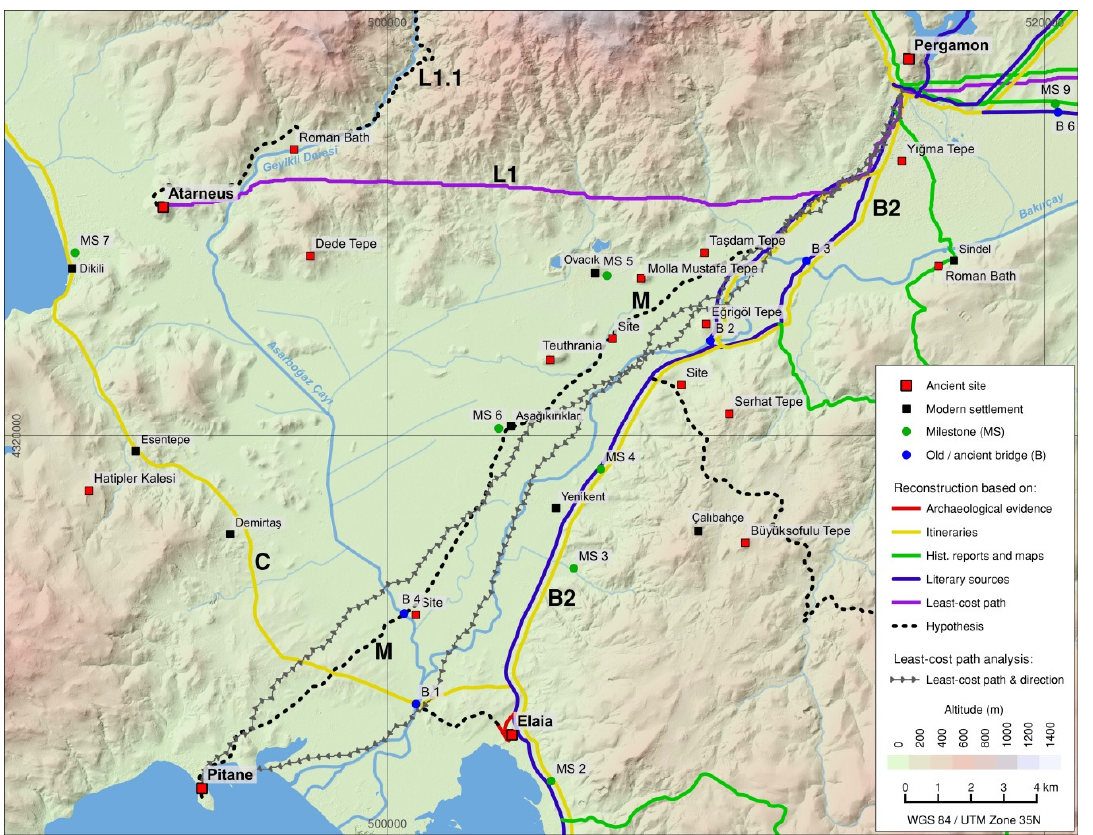
Figure 24. Calculated least-cost paths and reconstructed route between Pitane and Pergamon.